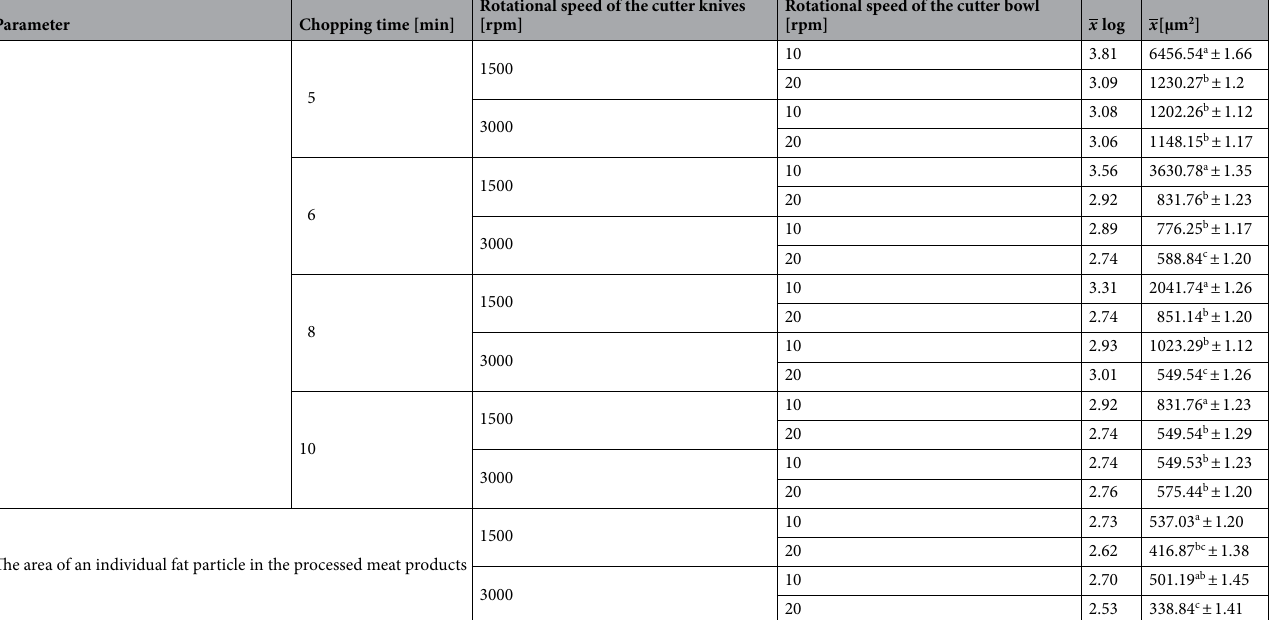
Table 2. The values of the area of an individual fat particle in the meat batter and processed meat products versus the chopping time and the rotational speed of the cutter knives and bowl (1500/10, 1500/20, 3000/10 and 3000/20 rpm).